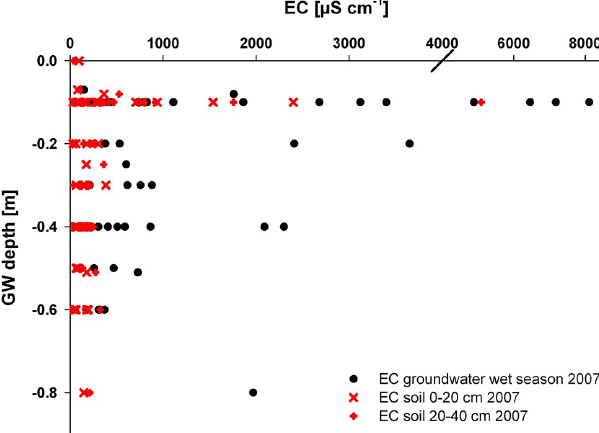
Fig. 5. EC in groundwater (wet season 2007) and two soil layers (May 2007) in relation to groundwater